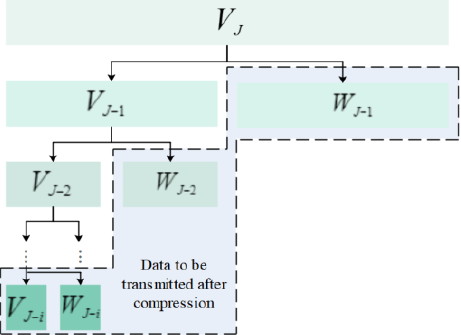
Figure 4. Schematic diagram of the data flow coming into the channel after compression.